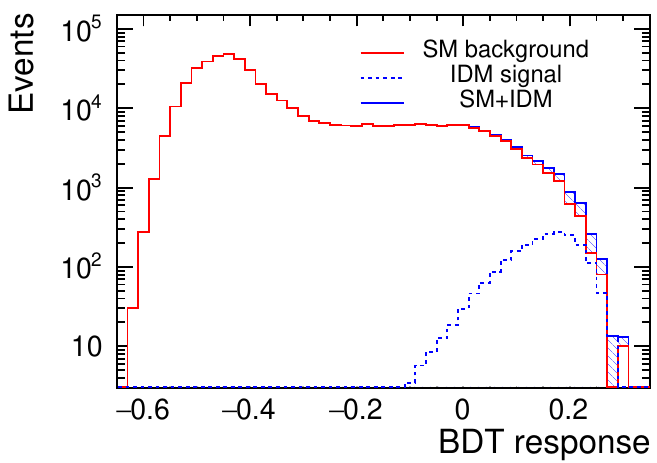
Figure 8 . Response distributions of the BDT classi(cid:12)ers used for the selection of H + H (cid:0) produc- p tion events at CLIC, at s = 380 GeV. Signal sample for BP1 scenario and SM background are normalised to 1 ab (cid:0) 1 .